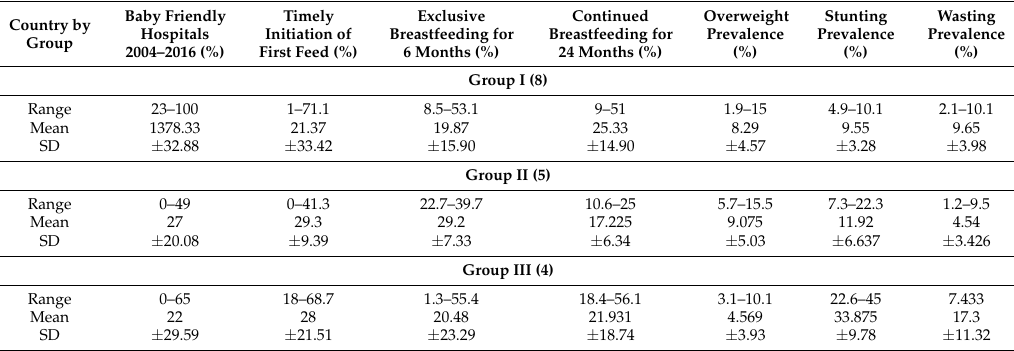
Table 3. Breastfeeding indicators, nutritional status, and percent Baby-Friendly hospitals, over the period from 2004 to 2016, in countries with advanced nutrition transition (group I), early nutrition transition (group II), acute and chronic malnutrition (group III), and countries with complex emergency situations (group IV) (expressed as mean and standard deviation and correlation coefficients)